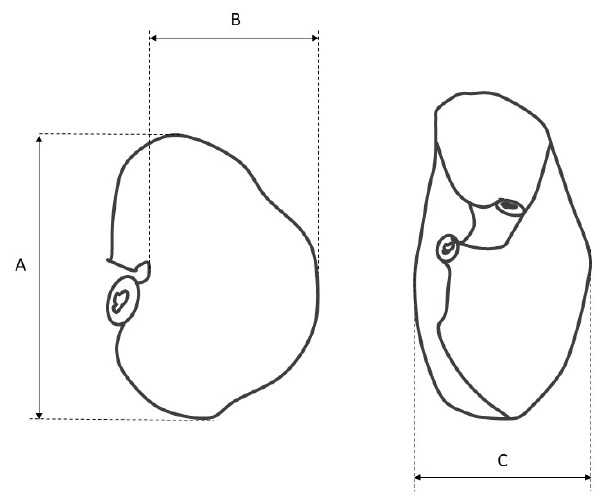
Figure 1. The scheme of the stomach morphometry. A—the length of the stomach; B—the width of the stomach; C—the thickness of the stomach.